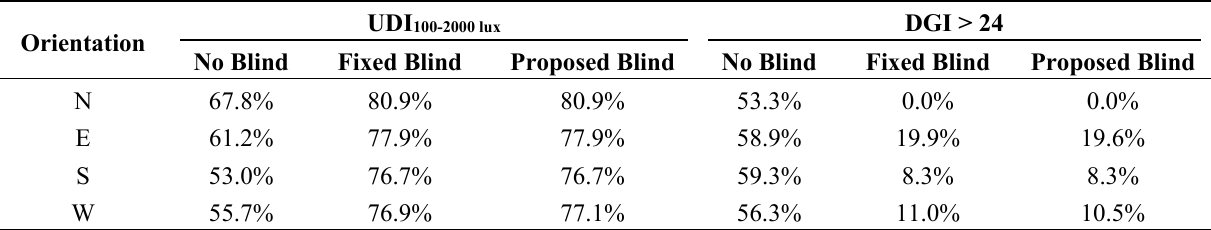
Figure 14. Temporal distribution map of UDI for the west facing case. ( a ) Without blind; ( b ) with fixed blind; ( c ) with the proposed blind. Table 5. Annual UDI and occurrence probability of disturbing/intolerable glare during occupied hours (DGI >